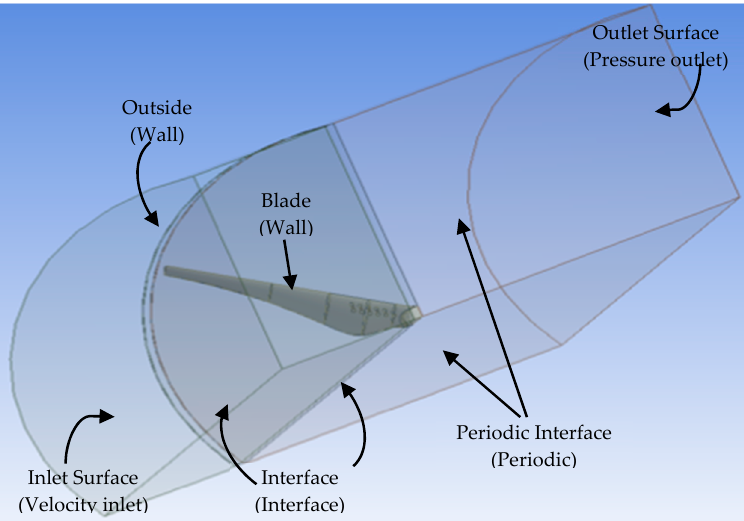
Figure 2. 3D periodic computational domain for single blade and boundary conditions.